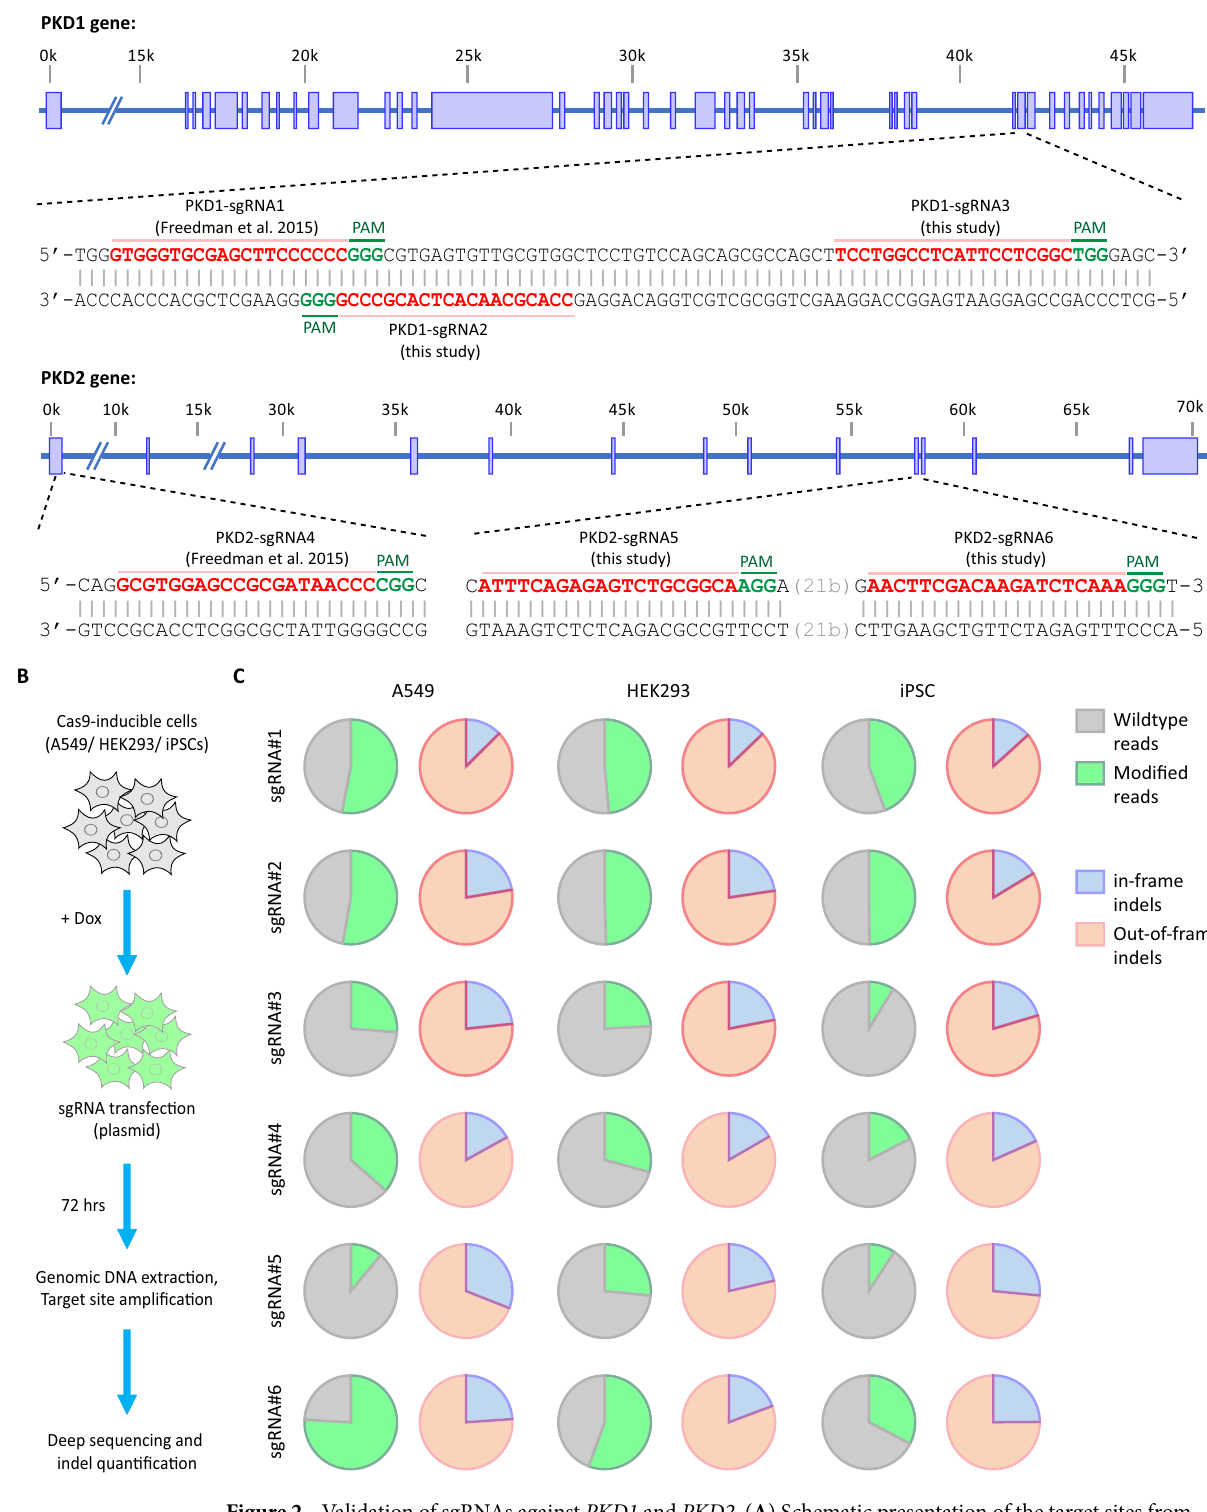
Figure 2. Validation of sgRNAs against PKD1 and PKD2 . ( A ) Schematic presentation of the target sites from previous report 23 and our study is shown. ( B ) Outline of the experimental procedure used for validation of the sgRNAs. Cells were seeded in 96-well format and Cas9 expression was induced before transfection with sgRNA- expressing plasmids. ( C ) The resulting Cas9-induced mutations at the target sites were measured using deep targeted sequencing. Mutations were further analyzed for their effect on the reading